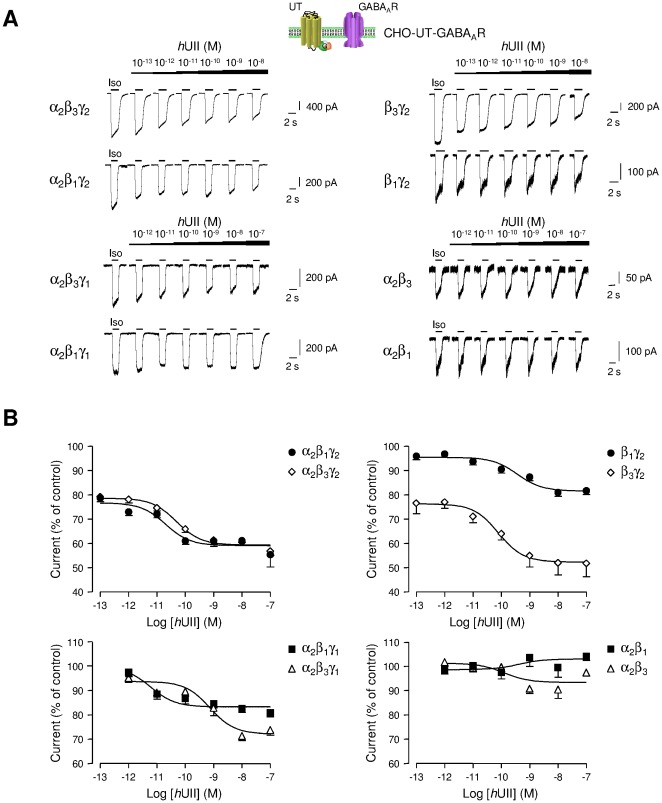
Effect of hUII on different GABAAR subunit combinations.(A) Typical Iso-evoked currents at the holding potential of −60 mV, in the whole-cell configuration, on CHO stably expressing human UT (CHO-UT) and transiently transfected with cDNAs encoding α2β3γ2, α2β1γ2, α2β3γ1, α2β1γ1, β3γ2, β1γ2, α2β3 or α2β1 subunits of the GABAAR. Iso (10−4 M) was repeatedly applied for 2 s at 2 min intervals and increasing concentrations of hUII (10−13 to 10−7 M) were bath perfused in the vicinity of cells. (B) Corresponding concentration-response curves for hUII on α2β1γ2 and α2β3γ2, α2β1γ1 and α2β3γ1, β1γ2 and β3γ2, α2β1 and α2β3 receptor subunits. Data are normalized to the control Iso response immediately prior to lower hUII concentration application. Data are mean ± SEM of 3 to 23 cells.